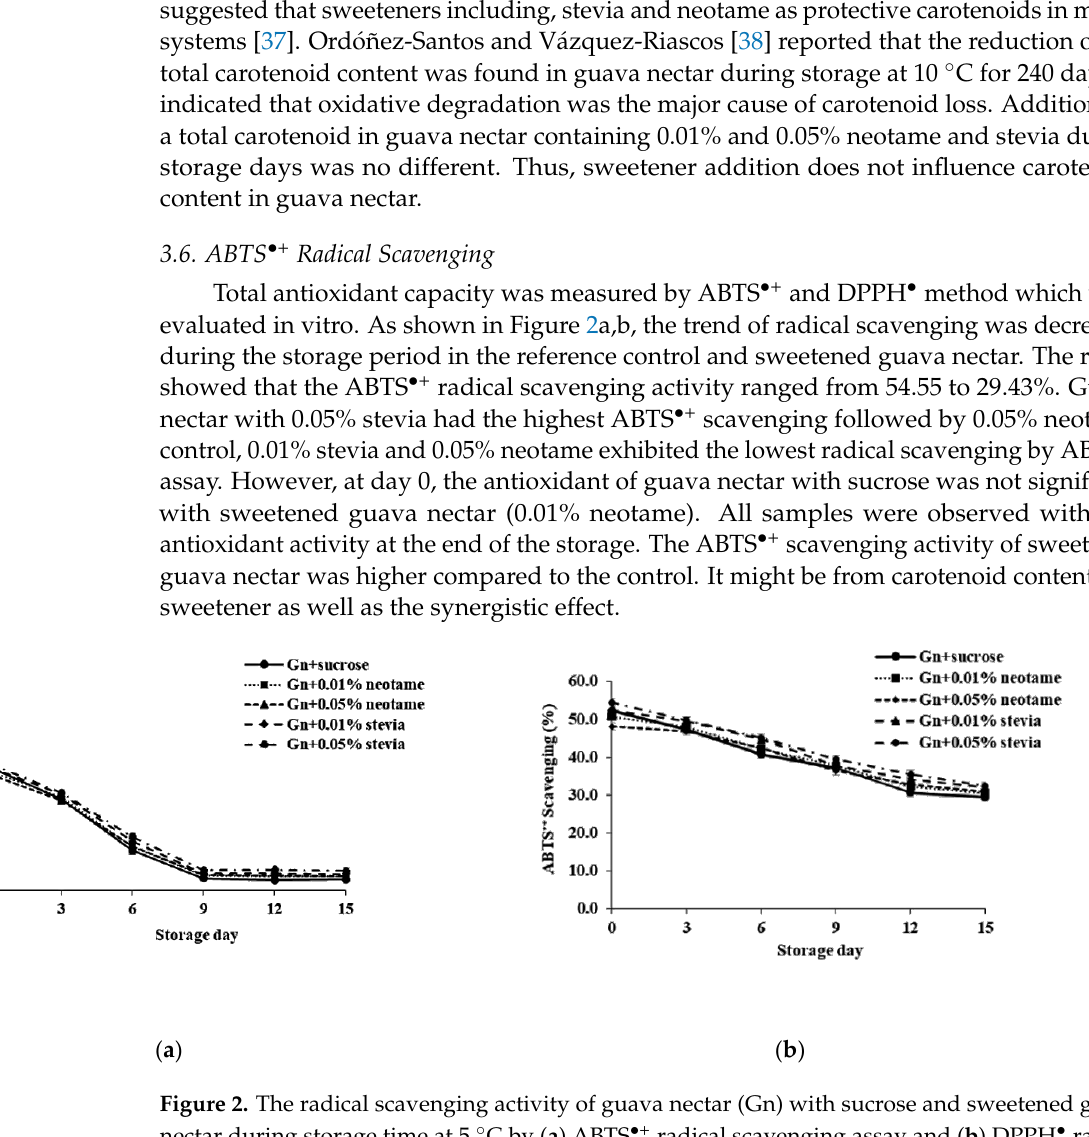
Figure 1. The effect of different sweetener on carotenoid content in guava nectar (Gn) with sucrose and sweetened guava nectar during storage time at 5 °C.